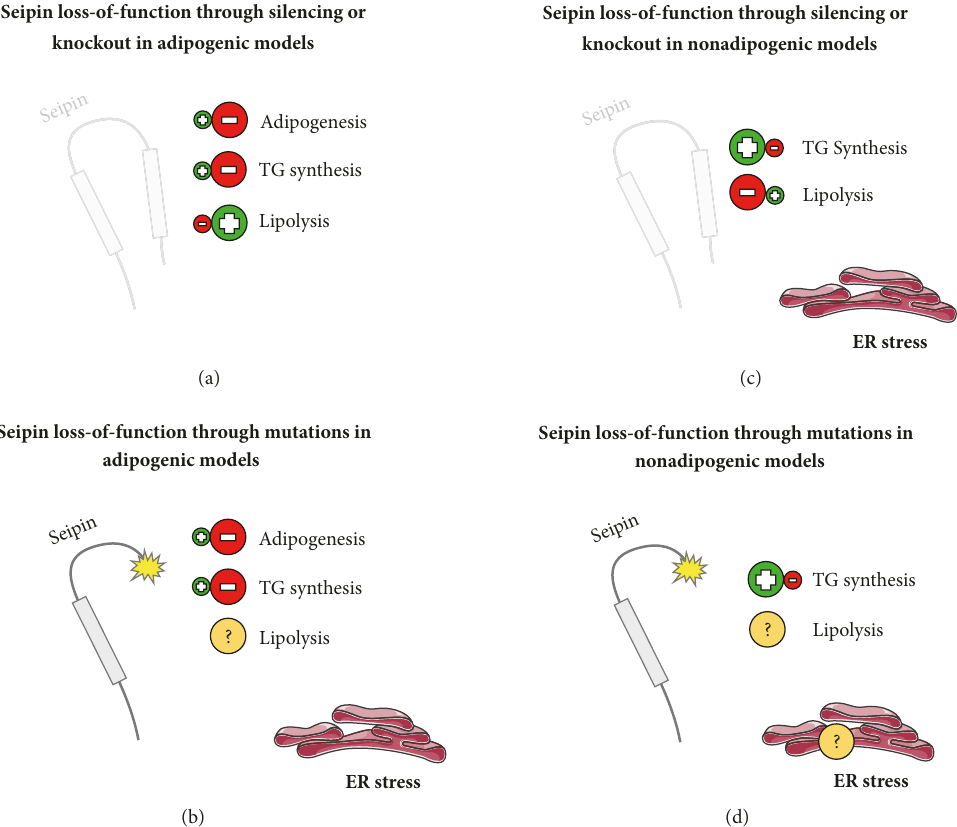
Figure 4: S eipin loss-of-function. We are proposing 4 different general models that usually happen with frequency under seipin loss- of-function. (a) Seipin loss-of-function through silencing or knockout in adipogenic models. Adipocyte maturation and TG synthesis are impaired, and ER stress was not found. (b) Seipin loss-of-function through mutations in adipogenic models. Adipocyte maturation and TG synthesisareimpaired,ERstresswaspositivelyfound,andthereisalackofinformationaboutthelipolysissituation.(c)Seipinloss-of-function throughsilencing or knockoutin nonadipogenicmodels.TG synthesis was increased,lipolysis is impaired, and ER stress was positively found; (d) seipin loss-of-function through mutations in nonadipogenic models. TG synthesis was increased, and there is a lack of information about ER stress and lipolysis. (b) and (d) are the most representative situations of Berardinelli-Seip congenital lipodystrophy (BSCL) type 2. Positive symbols represent a process that is usually increased, while the negative symbols represent the opposite. The interrogation symbol represents a process that needs to be studied further. Pieces of the illustrations are from the SMART website